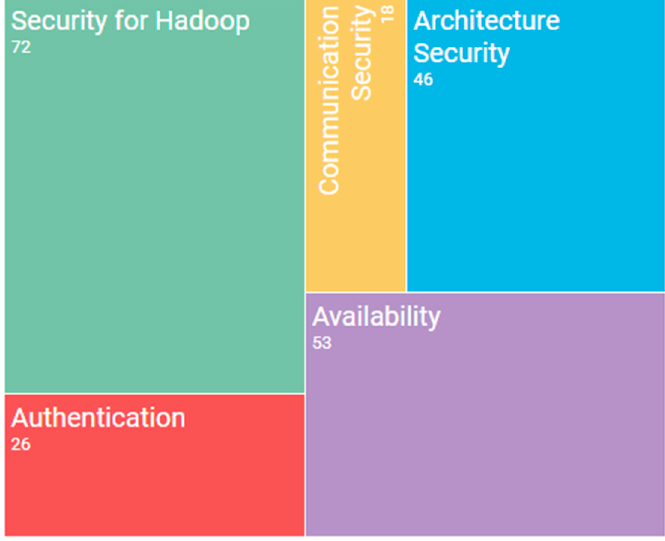
Figure 3. Main topics regarding infrastructure security.